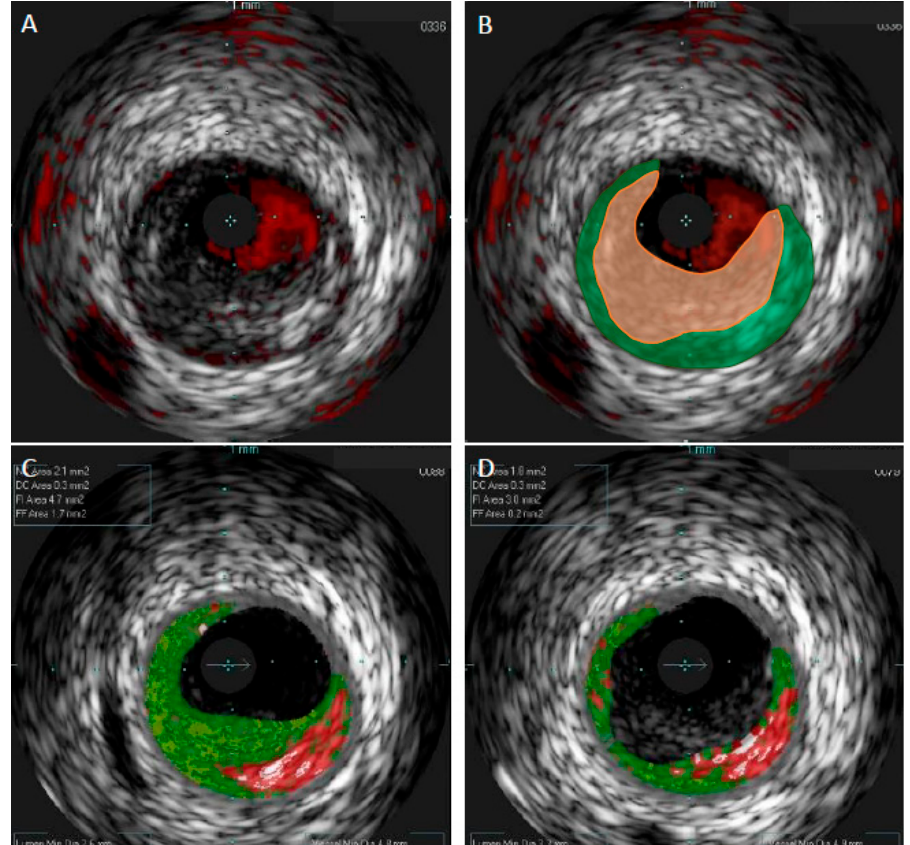
Figure 2. Comparison of gray-scale intravascular ultrasound and virtual histology intravascular ultrasound in patient with acute coronary syndrome. In gray-scale intravascular ultrasound (GS- IVUS), cross-section with lumen narrowing could be interpreted as soft plaque ( A ). However, on live image, motion and oscillation of the “plaque” were visible—image typical for thrombus. After postprocessing, thrombus (orange zone) was separated from true plaque (green zone) in GS-IVUS ( B ). In the same patient virtual histology intravascular ultrasound (VH-IVUS) marked thrombus as fibrotic plaque ( C ). Only after postprocessing could visualization of real borders of the plaque be presented ( D ).